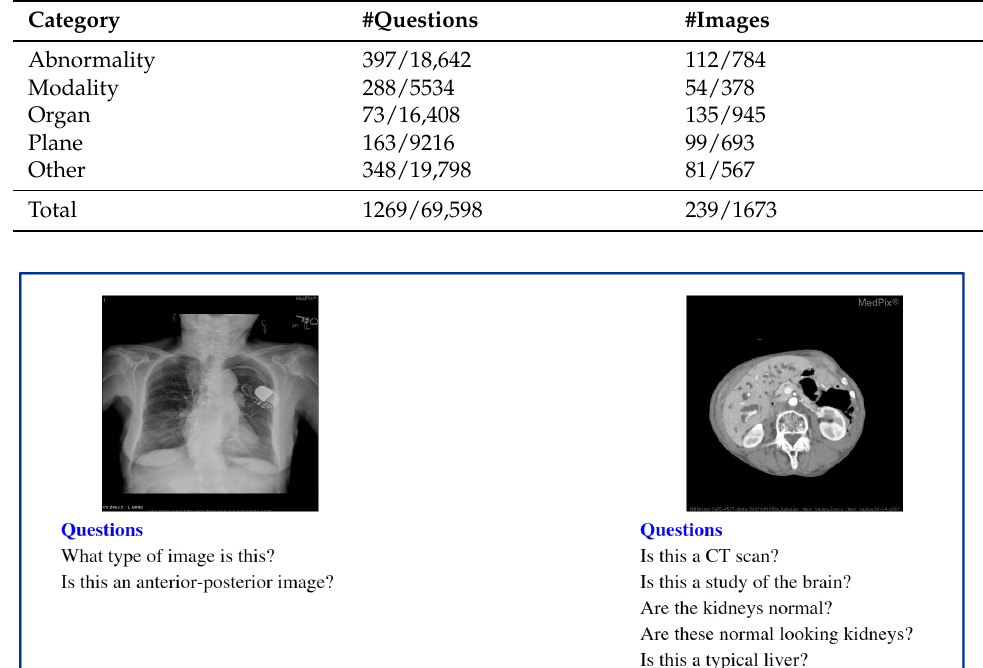
Table 1. The number of questions and images associated with each category. The values after “/” represent the number of questions and images created by our data augmentation techniques.